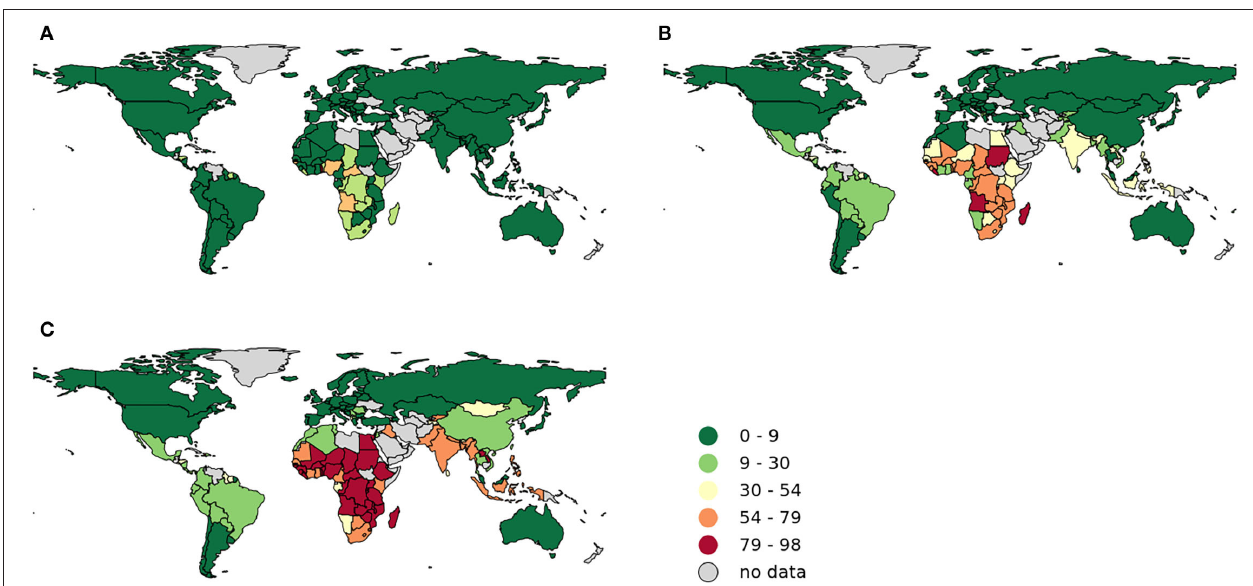
FIGURE 4 | Affordability of (A) energy sufficient diet, (B) nutrient sufficient diet, and (C) healthy diets. Higher values (in red) indicate the food is too expensive and not affordable to local population. The affordability is measured by the percentage of people in each country whose household income cannot afford the cost of the cheapest diets using locally available items, assuming they can spend no more than 63% of their income on food. For a given country, energy sufficient diet provides enough calories and is based on the least-cost staple foods, nutrient sufficient diet provides not only sufficient calories but also adequate amounts of essential nutrients, and healthy diets meet the national food-based dietary guidelines (FBDGs). Values were obtained from Herforth et al.